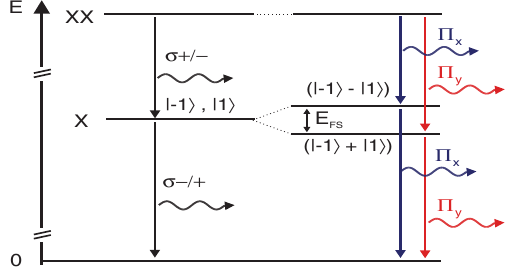
Figure 5: Excitonic and biexcitonic recombination of an InAs/GaAs QD without piezoelectric (left) and with piezoelectric effects, which lower the symmetry from C The polarizations of the transitions are